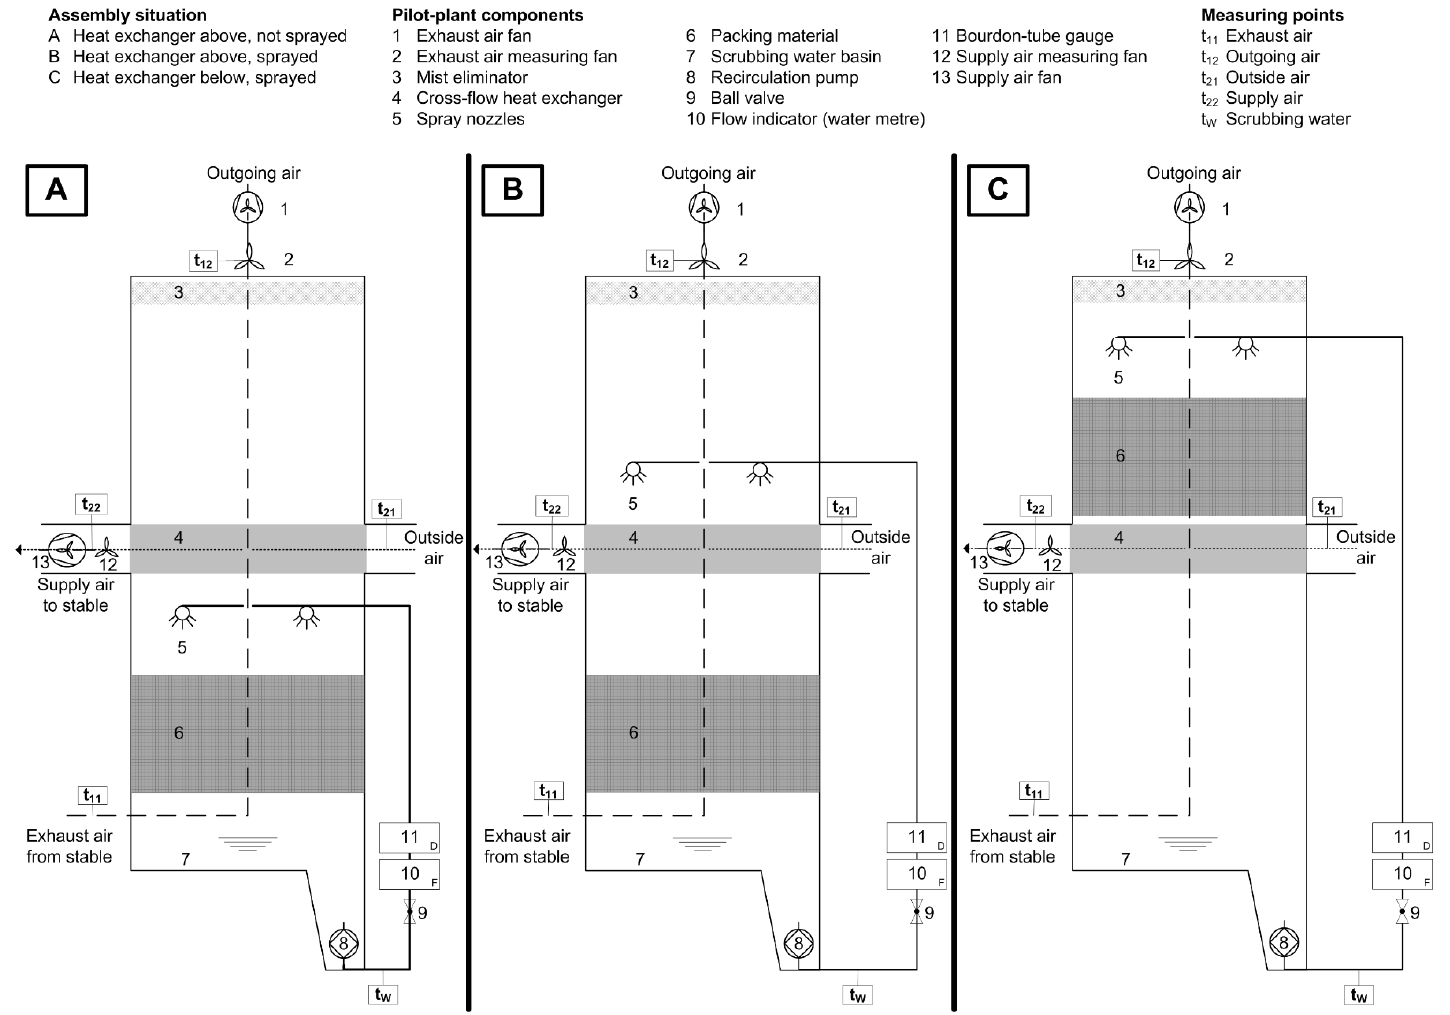
Figure 3. Schematic sketch of the exchange scrubber pilot plant with the three tested assembly situations of the heat exchanger unit. ( A – C ) indicate the assembly situation of the heat exchanger, numbers 1–13 the components of the pilot plant, and t the measuring points.